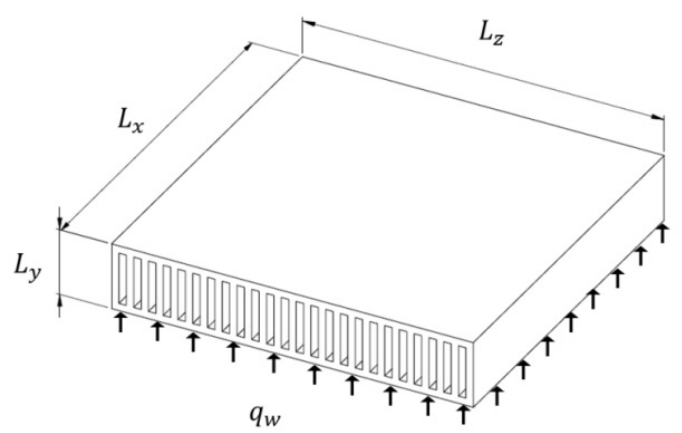
Figure 1. Schematic diagram of the micro multi-channel heat sink.